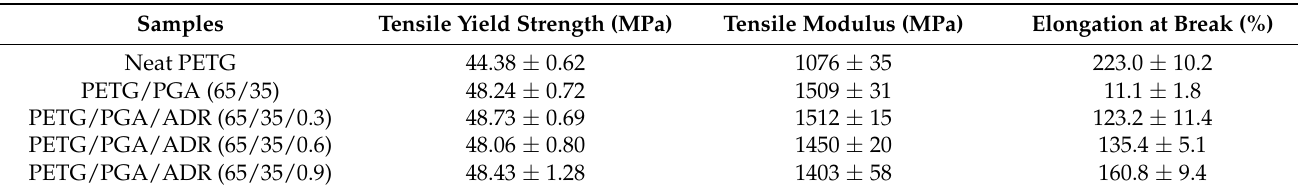
Table 4. Tensile performance of neat PETG and PETG/PGA/ADR (65/35/x)